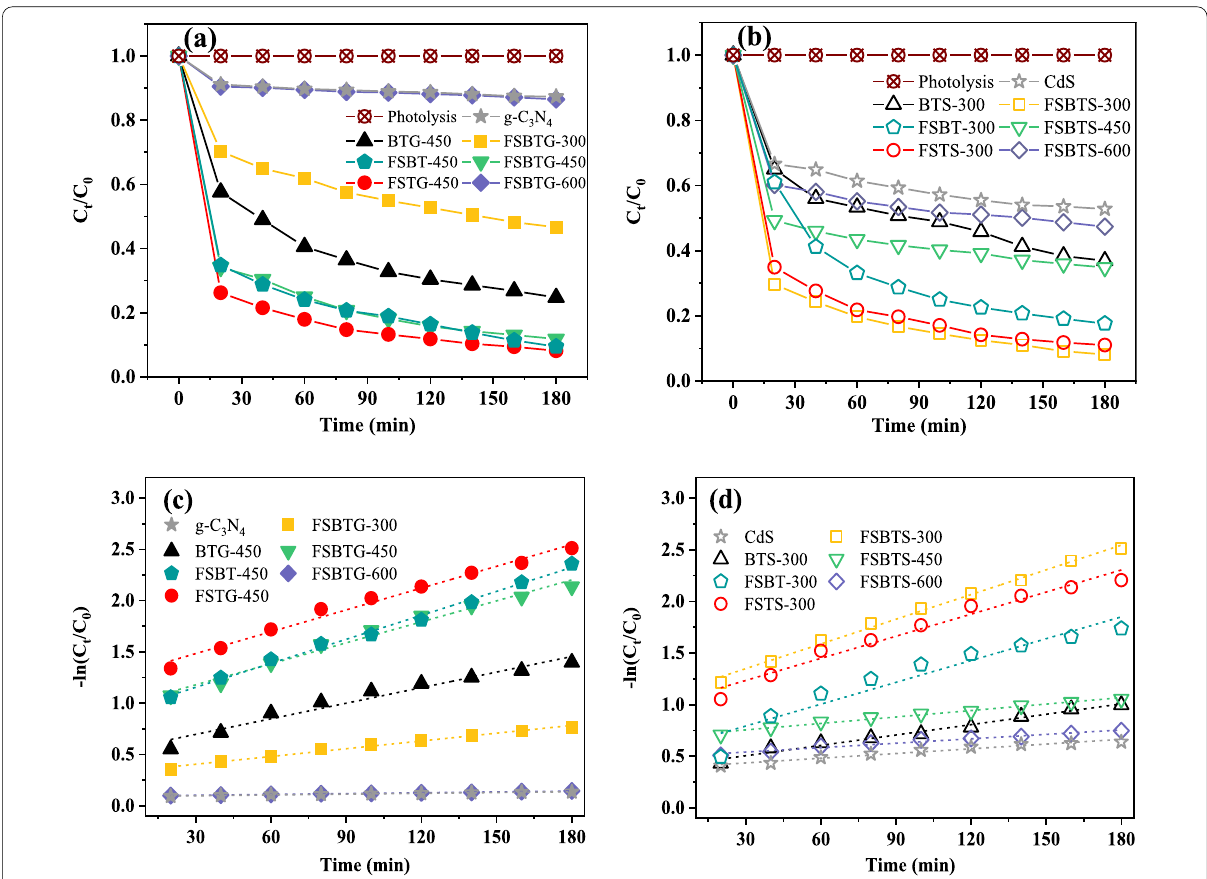
Fig. 5 Photodegradation curves and degradation kinetic curves of TC with g-C 3 N 4 -based photocatalysts ( a , c ) and CdS-based photocatalysts ( b , d ) (TC: C 0 200 mg L − 1 , 100 mL; photocatalyst dosage: 0.10 =